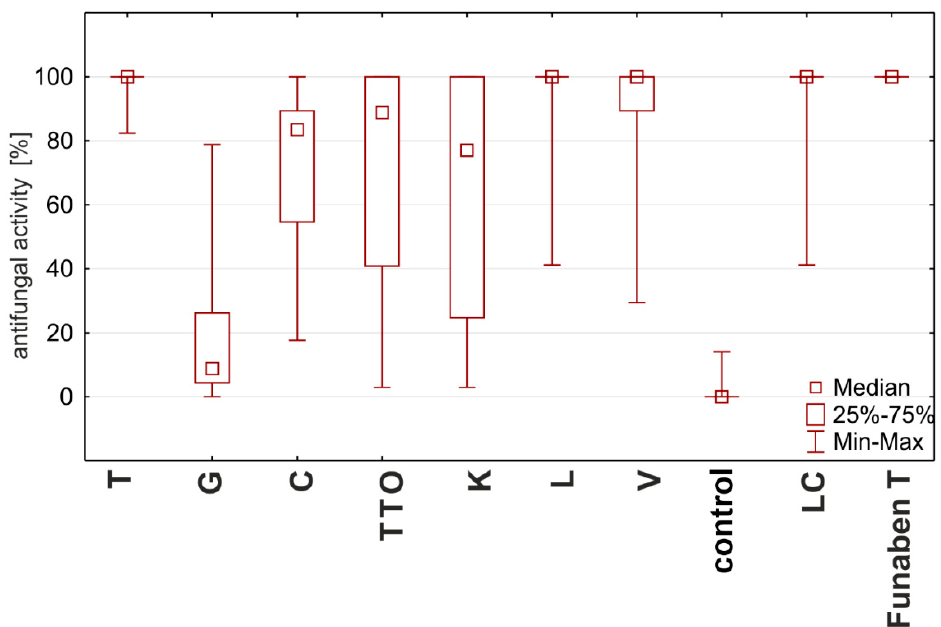
Figure 7. Characteristics of the fungistatic activity of the tested essential oils and Funaben T in relation to isolates of Fusarium ssp. [%]: T—thyme; G—grapefruit; C—garlic; TTO—tea tree; K—cajeput; L—lemongrass; V—verbena; LC— Litsea cubeba .